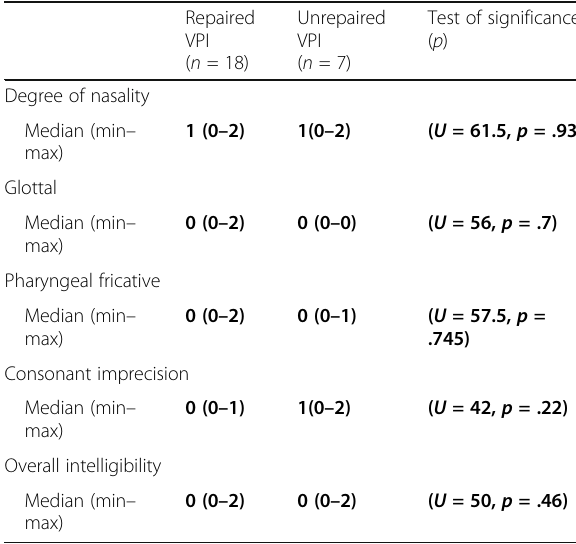
Table 4: Comparison between repaired and unrepaired Table 5 Comparison between mean of nasometer values velopharyngeal insufficiency regarding post-intervention degree before and after the intervention of auditory perceptual assessment of speech Nasometer values Pre Post Test of sig. Repaired Unrepaired Test of significance VPI VPI ( p ) ( n = 18) ( n = 7) Degree of nasality